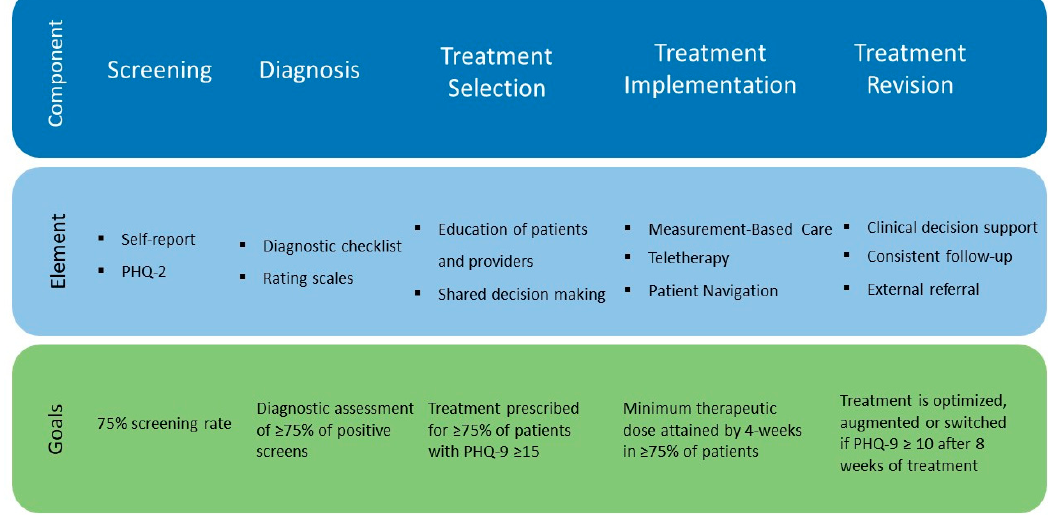
Figure 1 . PCP-First: A phased approach to adoption and achievement . Figure 1. PCP-First: A phased approach to adoption and